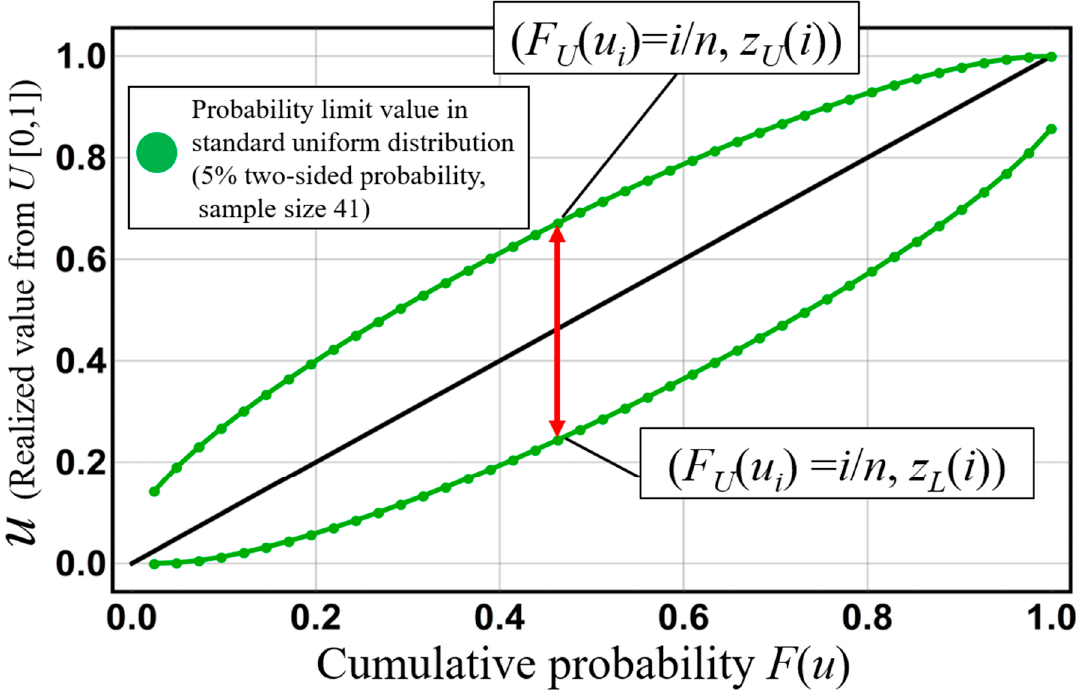
Figure 6. Probability limit line of probability limit method test for standard uniform distribution in the case of 5% two-sided probability and sample size 41.